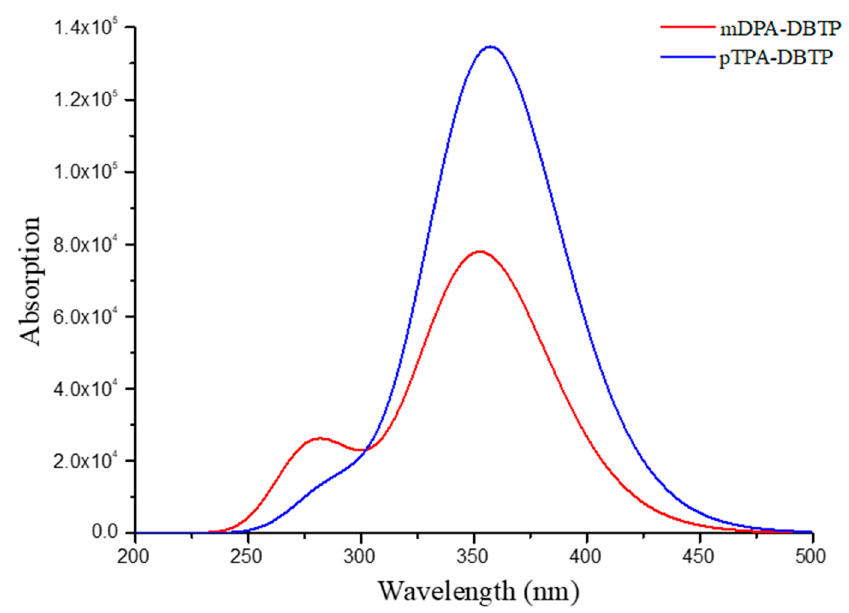
Figure 3. Ultraviolet-visible (UV-vis) absorption spectra of two investigated molecules in solution.